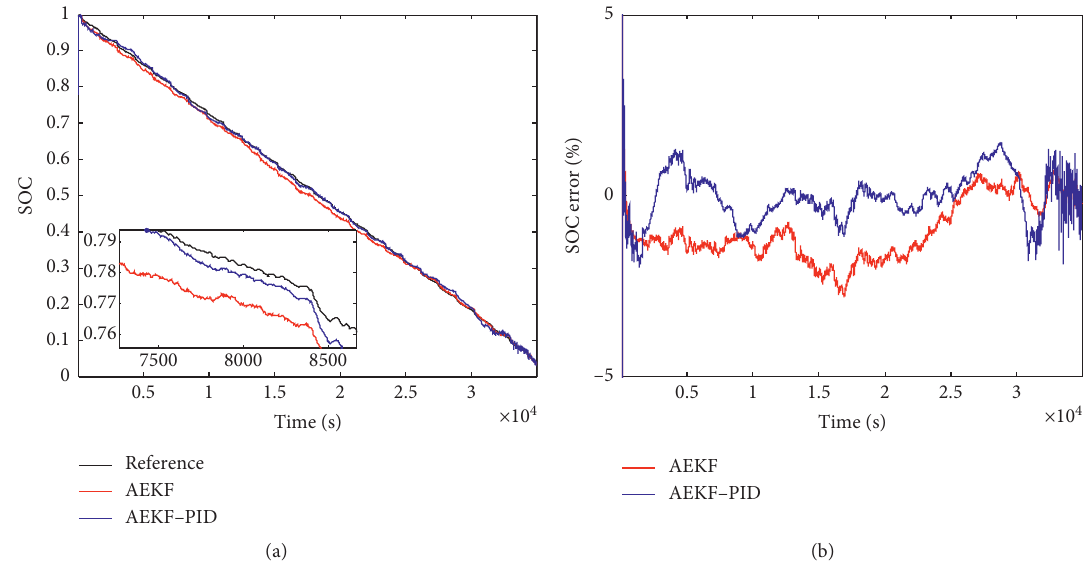
Figure 14: Comparison of SOC estimation with Gaussian noise under FUDS: (a) SOC estimation result; (b) SOC estimation